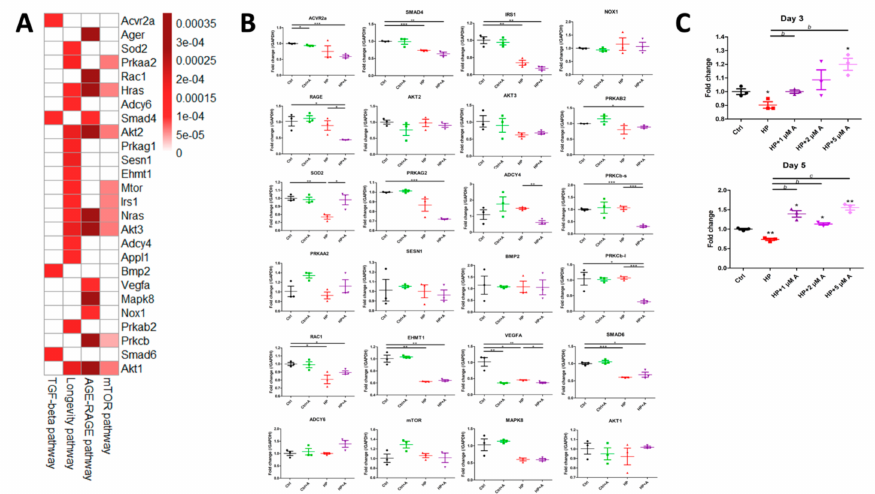
Figure 5. Validation of hub gene expressions in vitro. ( A ) Another heat map showing the closeness scores of the 26 early hub genes. ( B ) Expression levels of early hub genes in VSMCs subjected to HP and control media with and without astaxanthin treatment. ( C ) SOD2 expression levels among VSMCs subjected to control or HP media with escalating concentrations of astaxanthin at day 3 ( upper ) and 5 (lower). * p < 0.05, ** p < 0.01, and *** p < 0.001 compared with Ctrl or the reference group; a p < 0.05, b p < 0.01, and c p < 0.001 compared with the HP group. A, astaxanthin; AGE,